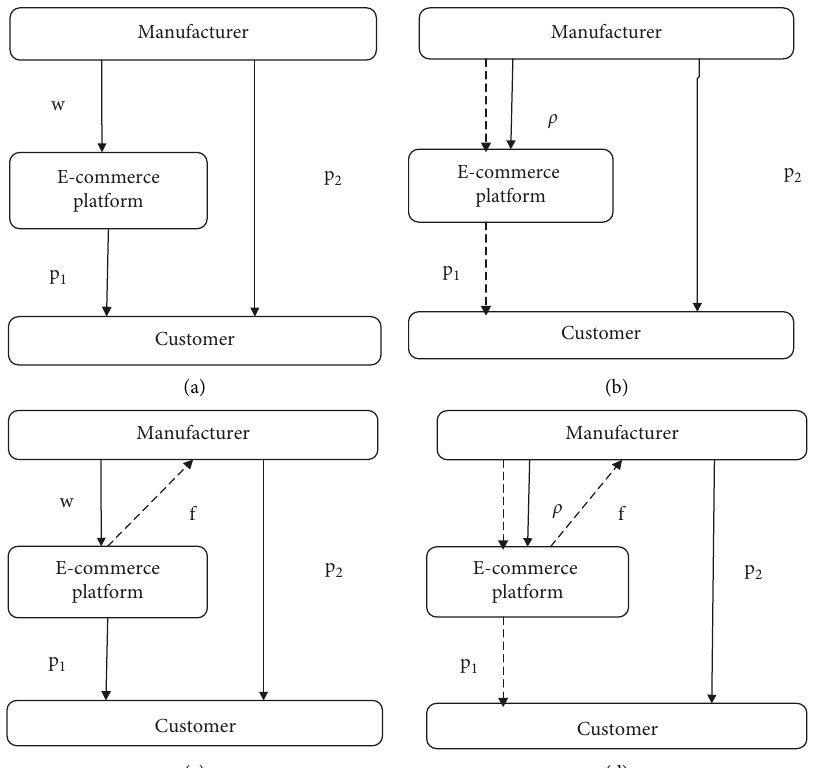
Figure 1: Dual-channel supply chain models. (a) Dual-channel supply chain models without block chain technology. (A) ND model: without block chain technology. On the one hand, in the distribution sales model, the manufacturer sells the product at wholesale price w